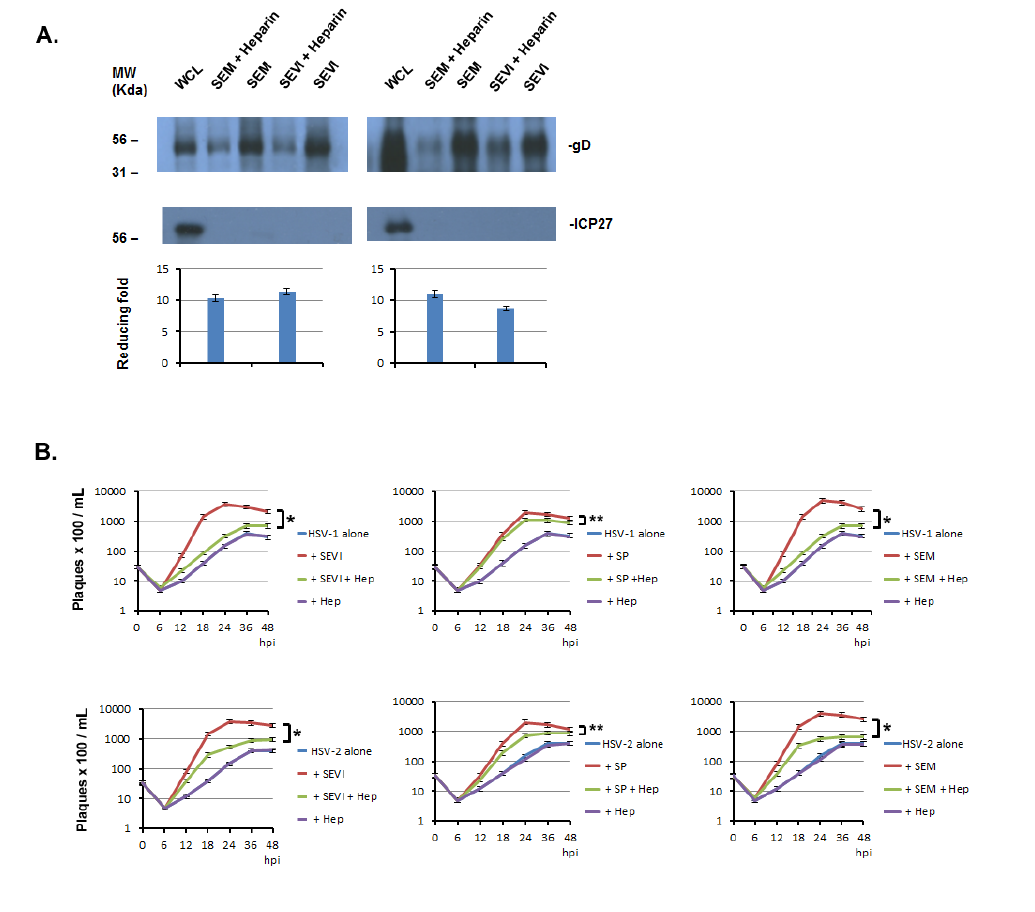
Figure 6. Heparin inhibits the amyloids’ enhancement of HSV infection. ( A ) Heparin interferes with the binding of HSV with amyloids. One milliliter of HSV-1 (10 7 /mL) was incubated with 5 μg of SEVI or SEM amyloid fibrils in the absence or presence of heparin (5 μg/mL) for 1 h at 37 °C. Controls included virus alone and virus incubated with 5 g of A-beta amyloid. The mixtures were centrifuged and the pellet was washed twice with MEM. The pellet was lysed in 2× Laemmli buffer and blotted using anti-ICP27 (non-structural protein) and anti-gD (envelope protein) antibodies. Whole cell lysates (WCL) of HSV-infected 293T cells were used as input controls for the Western blot. The density of the gD bands of HSV-1 or HSV-2 from non-heparin treated was compared with that of treated heparin, the fold increase of gD levels for HSV-1 (left) and for HSV-2 (right) were calculated (Quantity One software, version 4.5.0, Bio-Rad Laboratories, Richmond, CA, USA) and are shown below the corresponding Western blots; ( B ) Heparin significantly reduced the enhancing effects of SEM or SEVI on HSV infection. PFU assays were conducted in Vero cells using the same protocol as that described in Figure 5, except that heparin (5 μg/mL) was used in these experiments. Student’s t -test was used to statistically analyze the differences between the group of virus treated with amyloid (SEM or SEVI) versus those between virus treated with amyloids plus heparin (Hep) ( * p < 0.001) or the differences between the group of virus treated with SP versus those between virus treated with SP plus heparin (Hep) ( ** p <